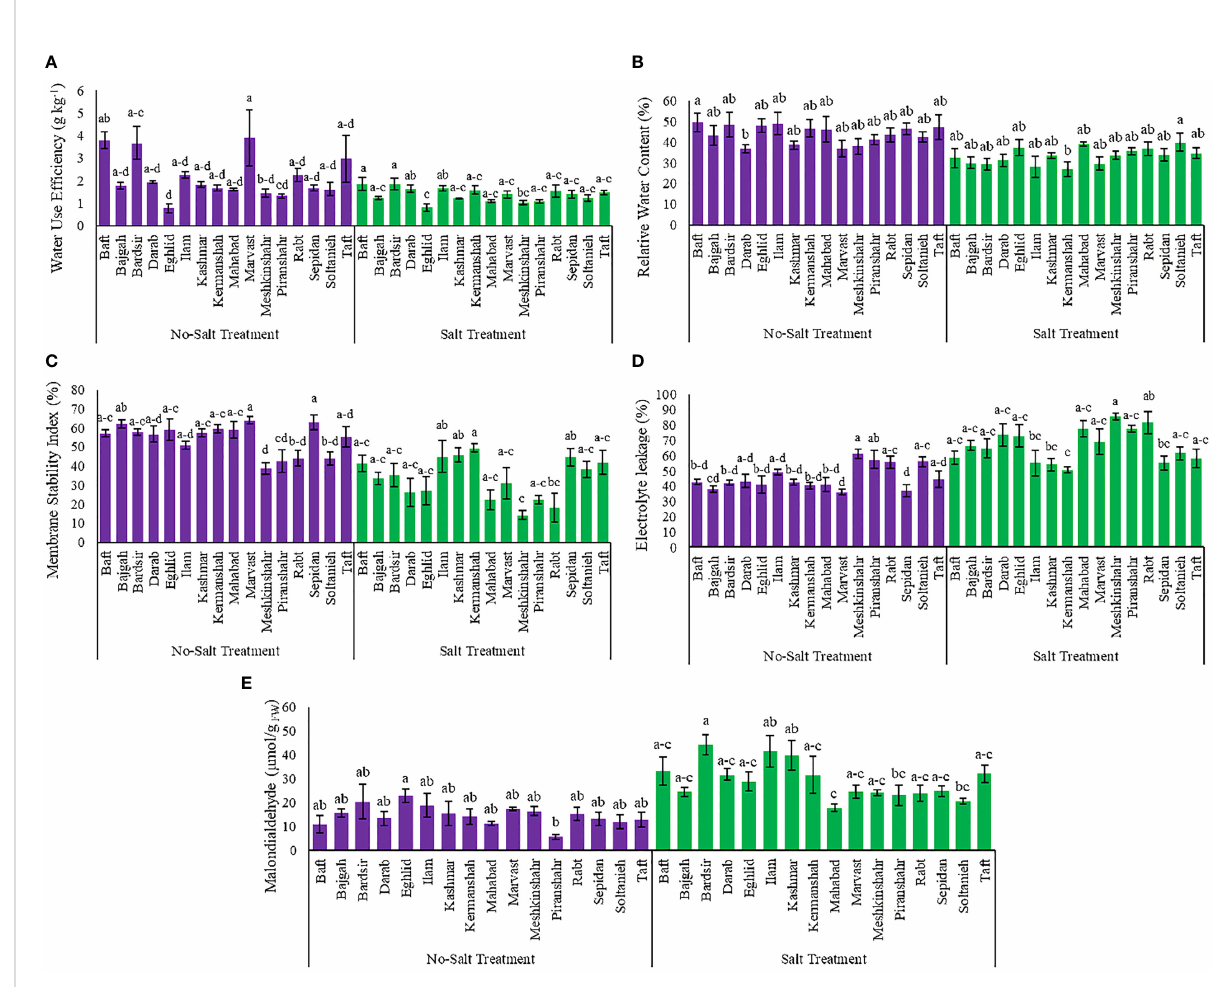
FIGURE 2 Measured parameters variation under studied treatments. (A) Water use ef fi ciency, (B) Relative water content, (C) Membrane stability index, (D) Electrolyte leakage and (E) Malondialdehyde. According to the analysis of variance, the above present mean comparisons are the only effects that showed signi fi cant difference. Mean values with the same letters are not signi fi cantly different ( p ≤ 0.05), Tukey test. Bars stand for standard error